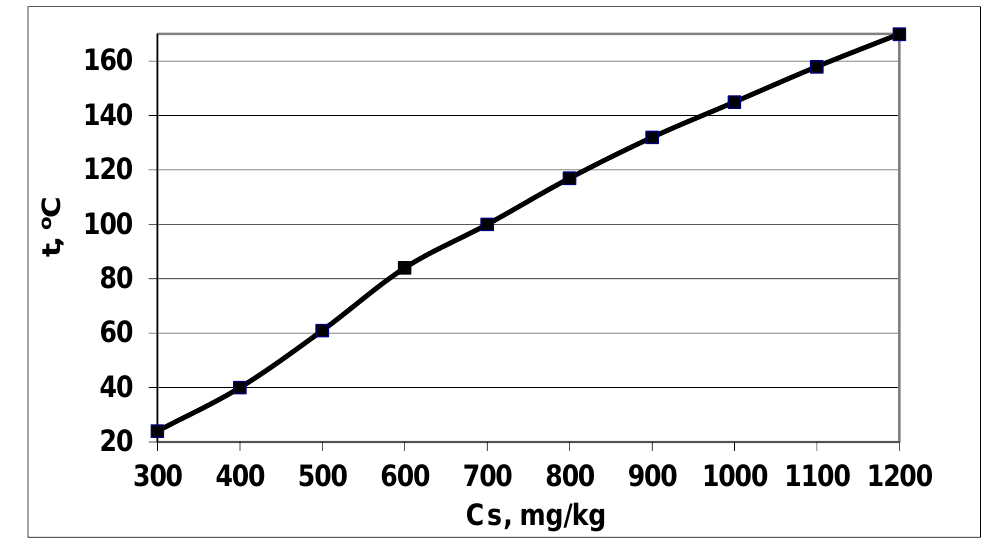
Figure 2. The temperature t (°C) corresponded to the maximum rate of molecular deposition R md at different concentrations C s , рН = 8.0.